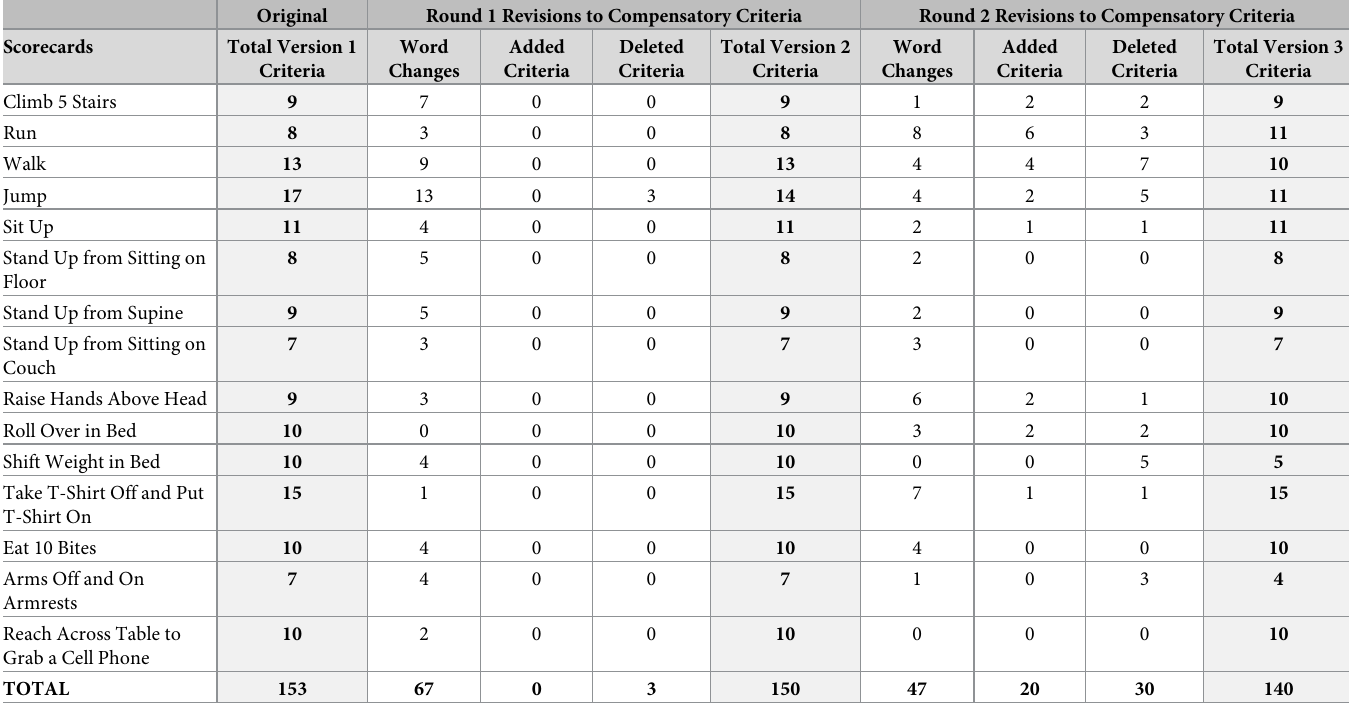
Table 2. Revisions to scorecard compensatory movement criteria after each Delphi panel